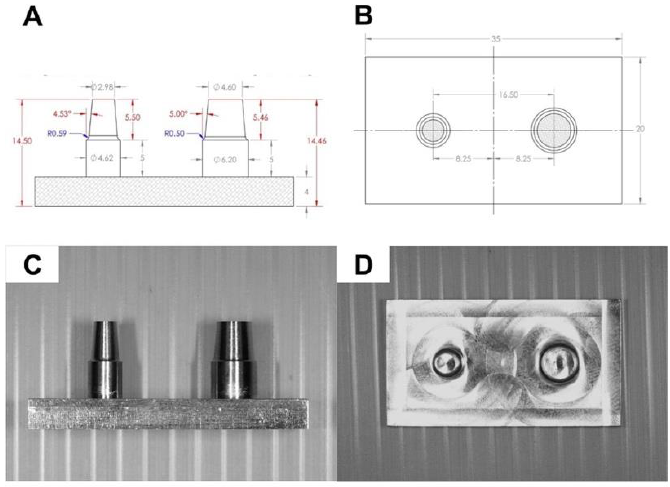
Figure 2. ( A , B ) Illustrations of CAD design and of an abutment model. ( C , D ) Photographs of a milled abutment model.